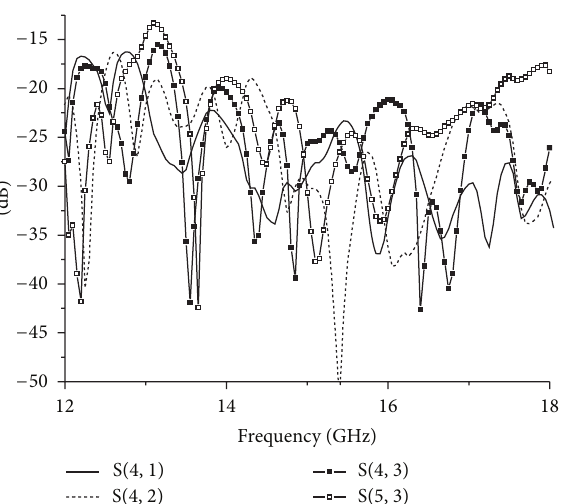
Figure 10: Isolation of the Rotman lens beam ports.